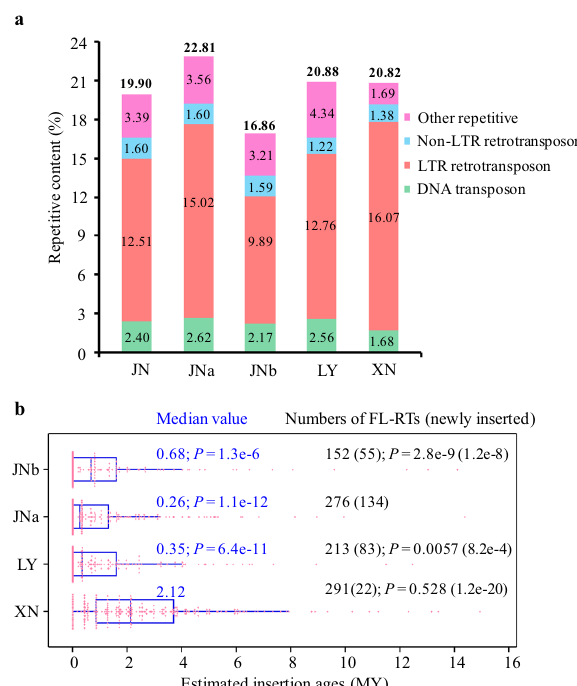
Fig. 2 Characterization of repeat elements in the Rhizoctonia LY, XN, and JN (JNa and JNb subgenomes). a Comparisons of repeat element compositions among genomes of LY, XN, and JN, and divided JNa and JNb subgenomes. Other repetitive representing Low_complexity, Simple_repeat, and Unknown repeat. The numbers in the columns mean the ratio of each repeat element category, and the numbers in bold on the tops of the columns are the total percentages of repeat elements. b Distribution of LTR-retrotransposon (LTR-RT) insertion ages in the Rhizoctonia data sets. The insertion time of each full-length LTR-RT (FL-RT) was estimated based on the divergence of the 5 ’ -LTR and 3 ’ -LTR ends using the formula “ T = K/2r ” ( K = divergence, r = 1.05 × 10 − 9 ). The median value of insertion ages and P values (Student ’ s t test) were shown in the fi gure with the age range from 0 to 14.93 for XN, 0 to 12.46 for LY, 0 to 14.37 for JNa, and 0 to 14.12 for JNb. The numbers of FL-RTs were also shown with the newly inserted (0 MY) in parentheses and followed by P values (binomial test) for comparison calculation against